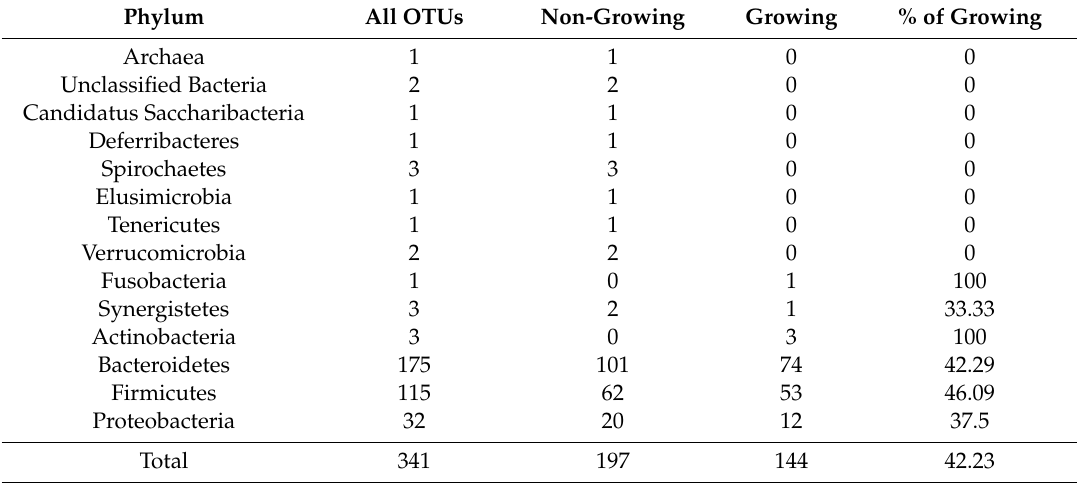
Table 2. Numbers of OTUs of the most abundant microbiota members in the chicken caecum assigned to di ff erent phyla and their ability to grow in